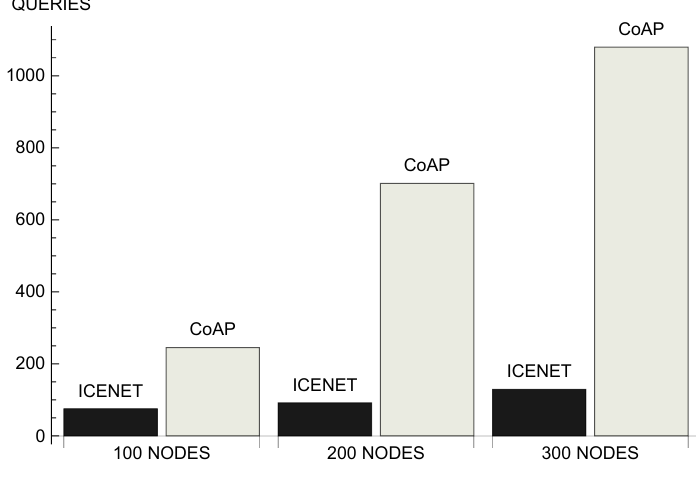
Figure 9. Number of queries forwarded by